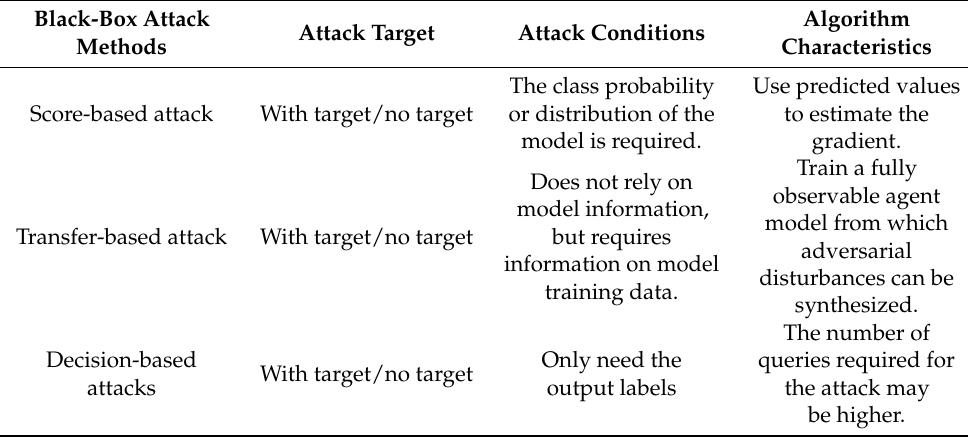
Table 1. Comparative analysis of three types black-box attack